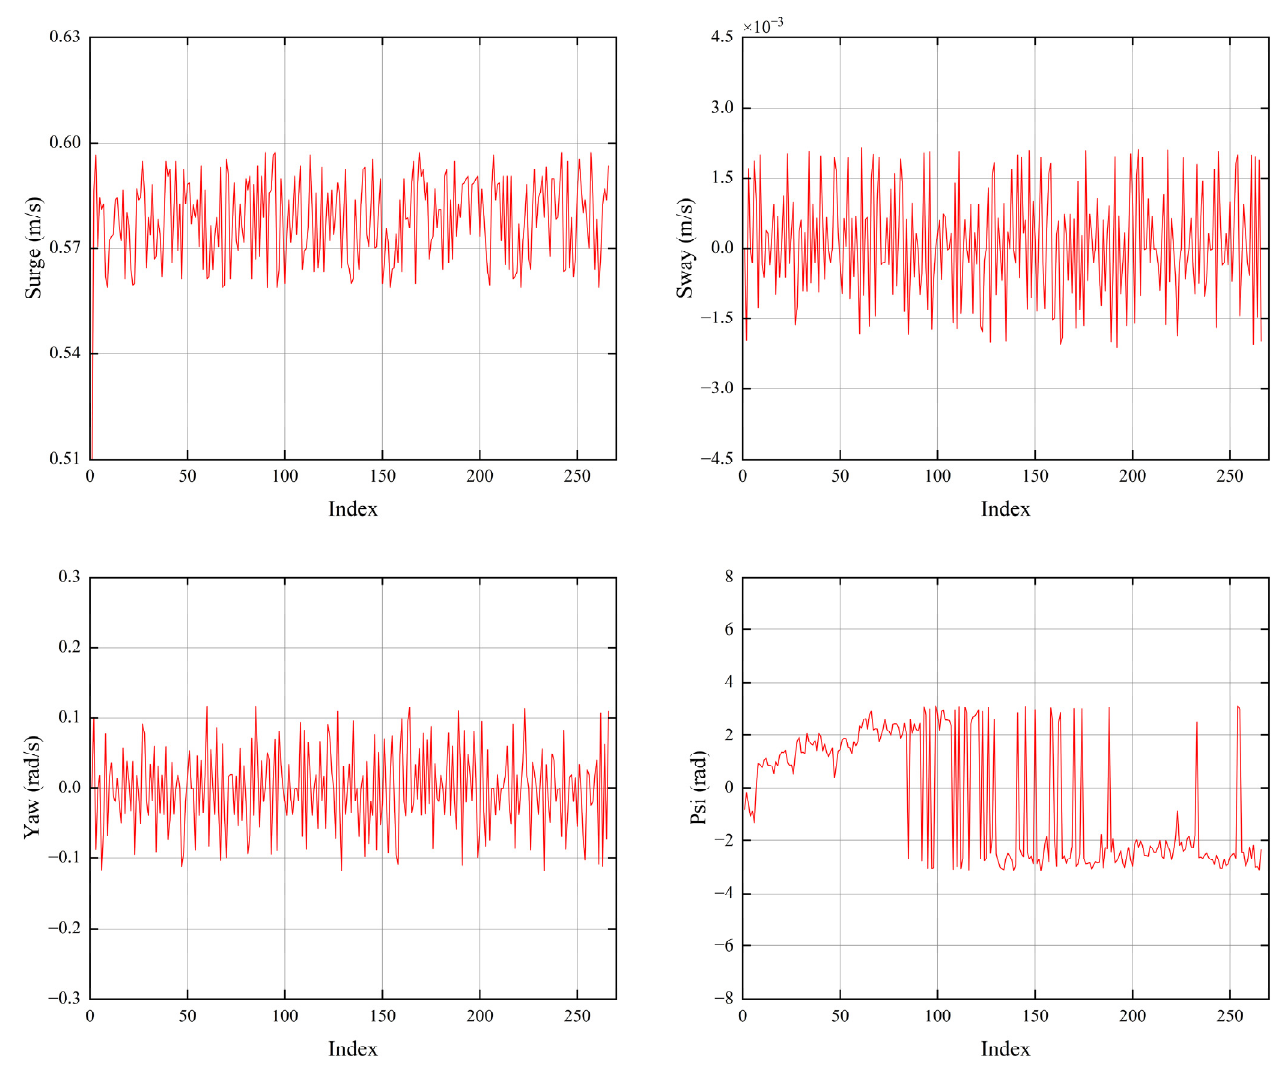
Figure 14. Navigation state information of the USV.